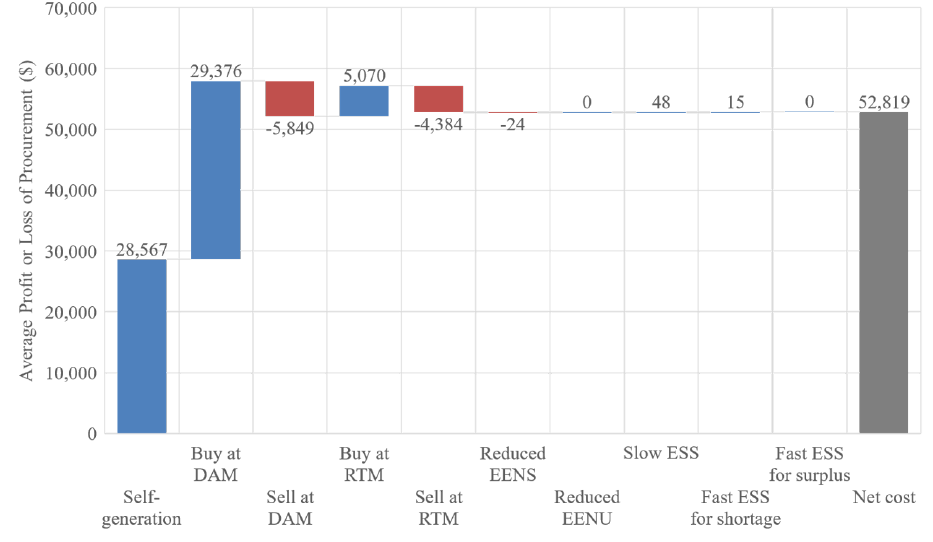
Figure 5. Average profit and loss of procurement. EENS, expected energy not supplied; EENU, expected energy not